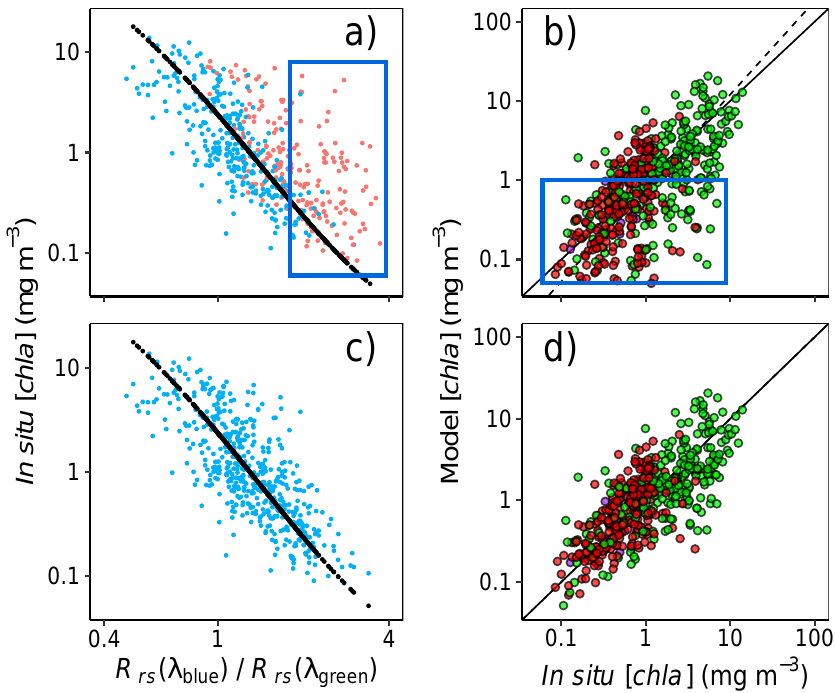
Figure 3. ( a ) In situ chla as a function of R rs ratio for POLY4 including the 443 nm band, where the blue dots represent the band ratios that used the 488nm band in the numerator and the pink dots used the 443nm band in the numerator, ( b ) Satellite-derived versus in situ chla when including the 443nm band in the ratio, where green and red circles represent spring and fall matchups respectively. ( c ) same as ( a ) but without including R rs ( 443 ) in the POLY4 algorithm, ( d ) same as ( b ) but without including R rs (443) in the POLY4